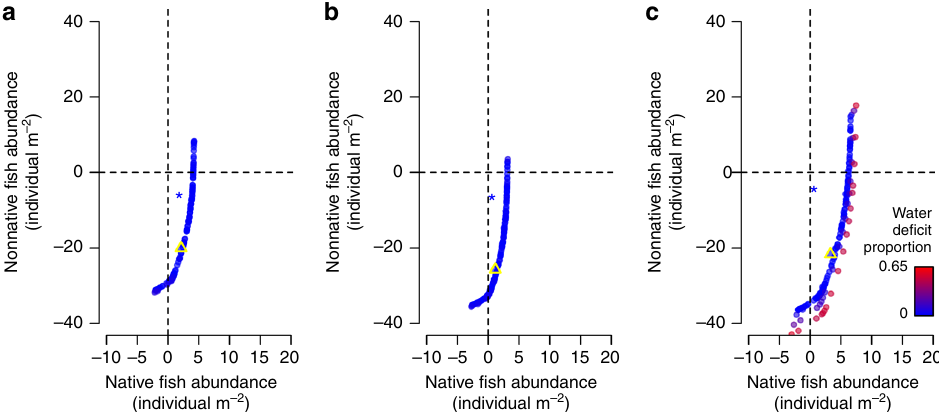
Fig. 2 Pareto frontiers depicting optimal fl ow designs for Navajo Dam. Designer fl ows differentially prioritized human water needs, average native fi sh abundance gains, and average nonnative fi sh abundance losses during the a wet (high- fl ow) period, b normal (average- fl ow), and c dry (low- fl ow) period. Predicted effects on abundances (individual m − 2 ) are on the log-scale averaged across all years, river reaches, and species within each scenario. Each point represents a different fl ow design. The triangle symbol in each panel designates sample fl ow design used for discussion of designer fl ow approach in main text. The star symbol in each panel indicates the outcomes of hypothetical natural fl ow mimicry with no de fi cit to human